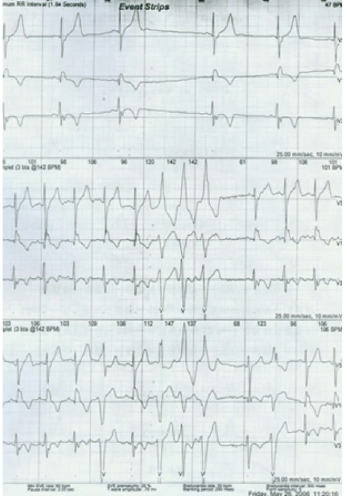
Figure 4: Holter ECG revealed frequent multifocal PVCs and nonsustained VT.